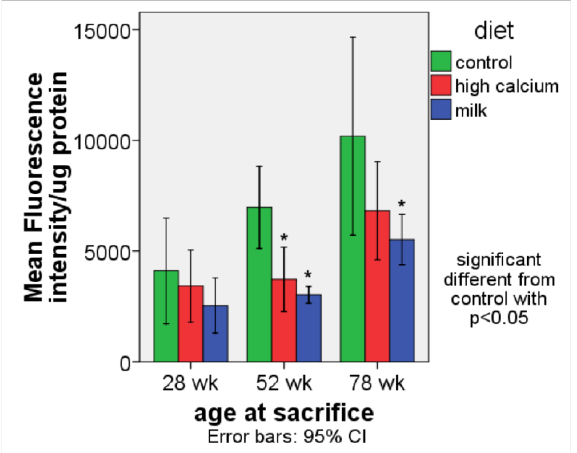
Figure 2. ROS production (expressed as fluorescence intensity/ μg protein) in white adipose tissue (retroperitoneal and perirenal fat) in aP2-agouti transgenic and wild-type mice (gender and genotype combined) fed control, high calcium or NFDM diets at 28, 52 and 78 weeks of age. Values are expressed as mean ± SE, ( n = 4–5). * Significant different from control, p < 0.05.